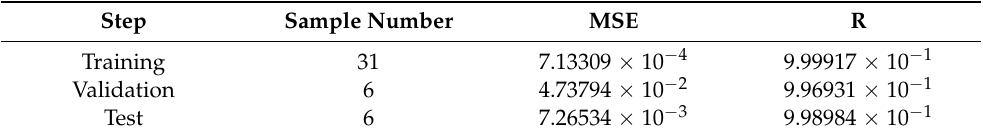
Table 3. Results of the ANN